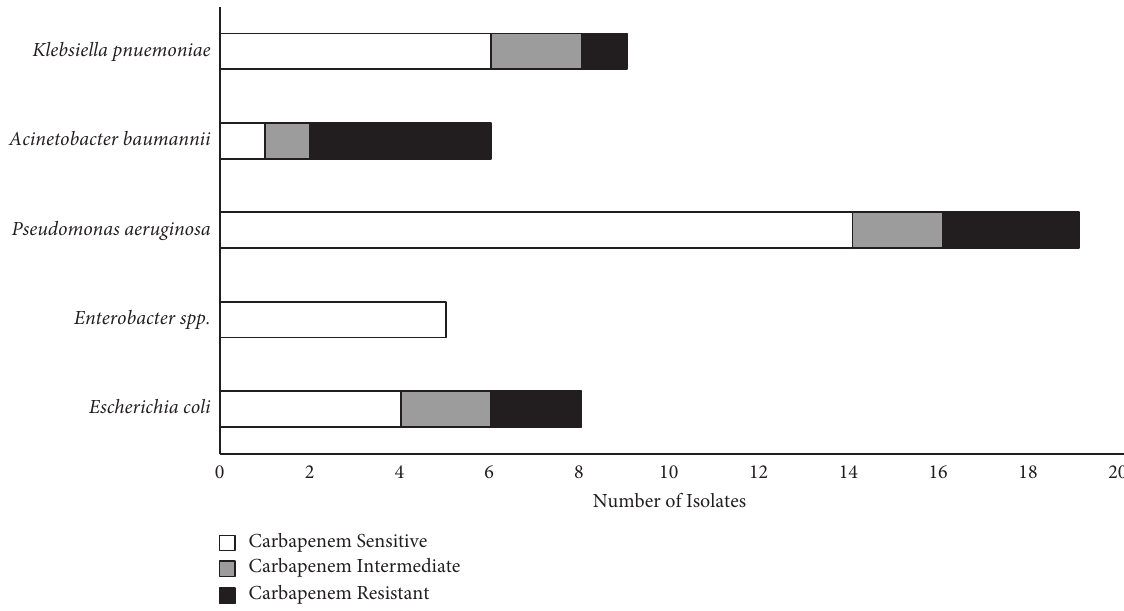
Figure 4: Resistance patterns of isolated gram-negative ESKAPE Pathogens. Carbapenems: sensitive, intermediate, and resistant were determined by CLSI 2019.